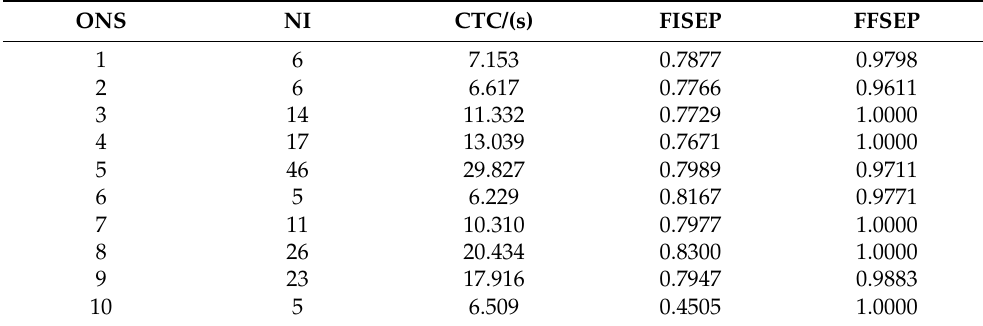
Table 3. Search information of detecting points for 10 random searches based on particle swarm optimization.